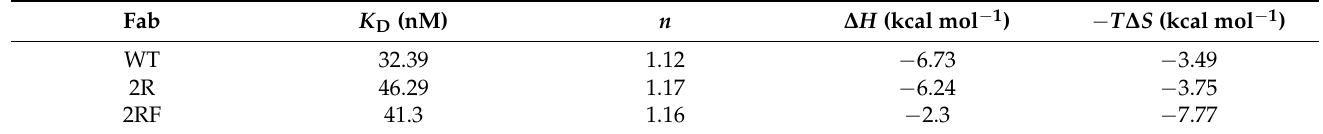
Figure 4. Binding comparison of helical MPER epitope in solution. ( A ) CD spectra of MPER 664–690 peptide in solution and increasing concentration of DPC micelles as indicated in the panel. ( B ) Binding isotherms of the peptide solubilized in 5 mM DPC to 10E8-WT, 10E8-2R and 10E8-2RF Fabs. Upper panels: heat released upon peptide–Fab interaction. Lower panels: Integrated heats (symbols) and non-linear least-squares fit (line) of the data to a one-site binding model. The thermodynamic binding parameters are shown in Table 1. Thermodynamic parameters of binding of Fab 10E8 and its mutants to the pep- tide MPER 664–690